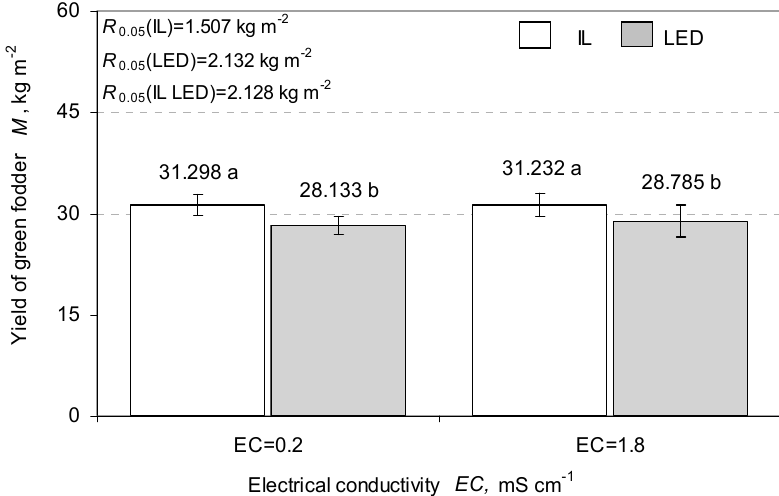
Figure 6. Influence of macro- and micronutrients on fodder yield with indoor lighting or LED and a tray slope angle of 6.5%. Each vertical bar is 95% confidence interval. Any two samples with a common letter are not significantly different ( p < 0.05), as assessed using the least significant difference.